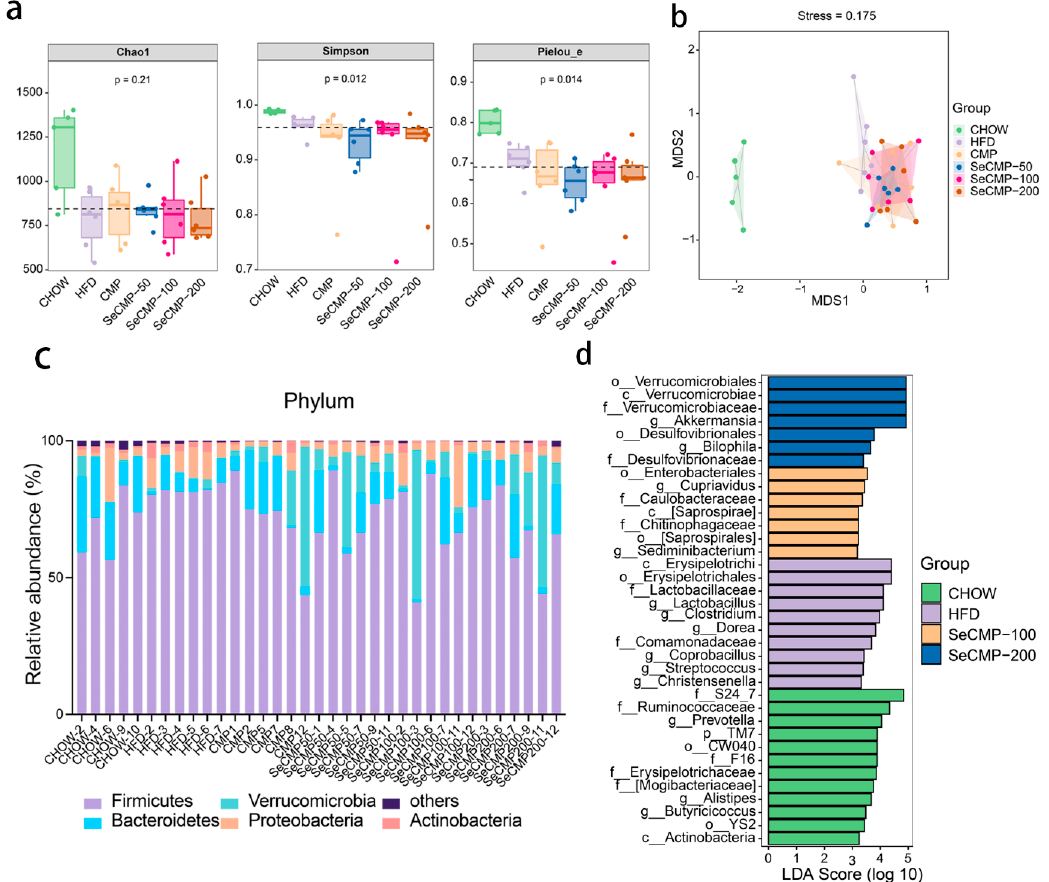
Figure 5. Difference in richness, diversity, and evenness of gut microbiota, relative abundance of bacteria at phylum level, and LEfSe analysis identified microbe biomarkers at genus level in mice fed with selenium-rich C. militaris crude polysaccharides (SeCMP) and selenium-deficient C. militaris crude polysaccharides (CMP). ( a ) Alpha diversity indexes of Chao1, Simpson, and Pielou’s evenness index. ( b ) Bray–Curtis distance based nonmetric multidimensional scaling (NMDS) (stress = 0.175). ( c ) Bacterial taxonomic profiling in the phylum level. ( d ) Main indicator taxa in each group based on LEfSe comparison (LDA score > 2). Data represent mean ± SE (n = 5–6 mice/group). CHOW: normal diet + sterile water; HFD: high-fat diet + sterile water; CMP: high-fat diet +100 mg/kg CMP; SeCMP-50: high-fat diet +50 mg/kg SeCMP; SeCMP-100: high-fat diet +100 mg/kg SeCMP; SeCMP-200: high-fat diet +200 mg/kg